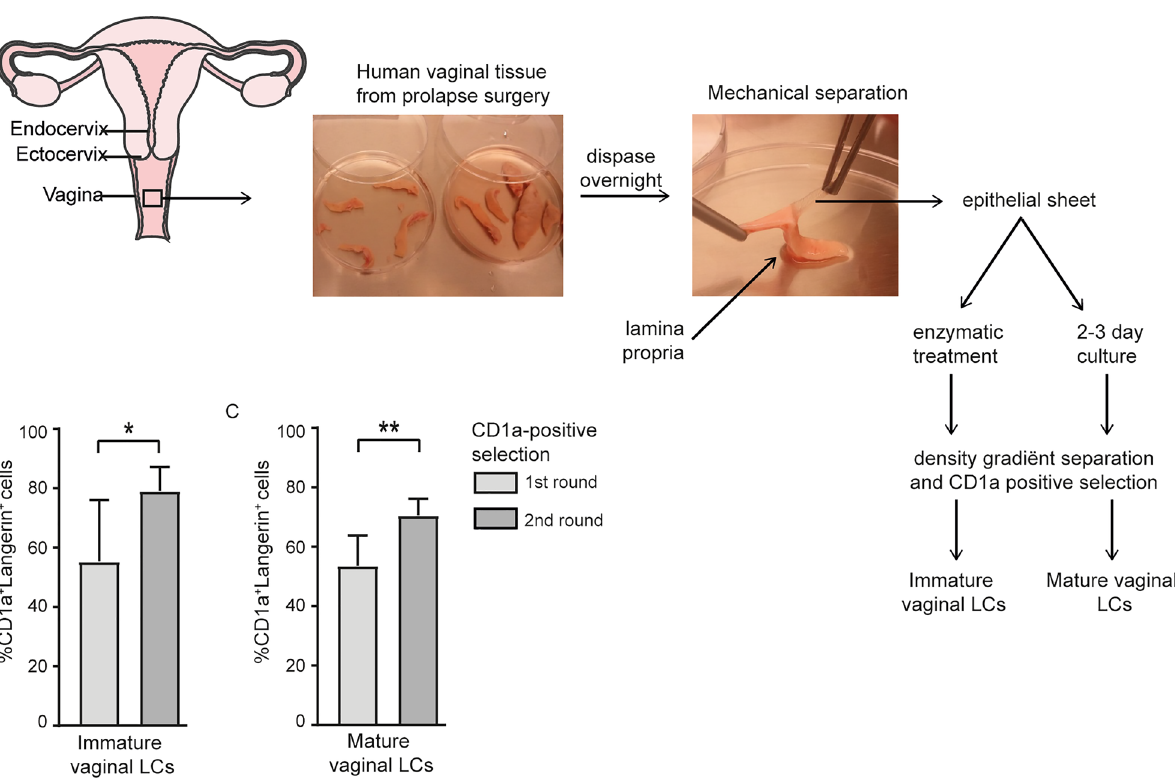
Figure 1. Vaginal LC purification. ( a ) schematic model and pictures of isolation procedures used to obtain immature and mature vaginal LCs from primary human vaginal tissue. Images were adopted from Servier Medical Art by Servier (http:// www. servi er. com/ Power point- image- bank) and modified by the authors under the following terms: CREATIVE COMMONS Attribution 3.0 Unported (CC BY 3.0); ( b,c ) vaginal LC purity (% CD1a + /Langerin high cells) after immature (( b ), N = 7) and mature (( C ), N = 6) isolation procedure. * p < 0,05, ** p < 0.01, two-tailed t- test, data are mean ±